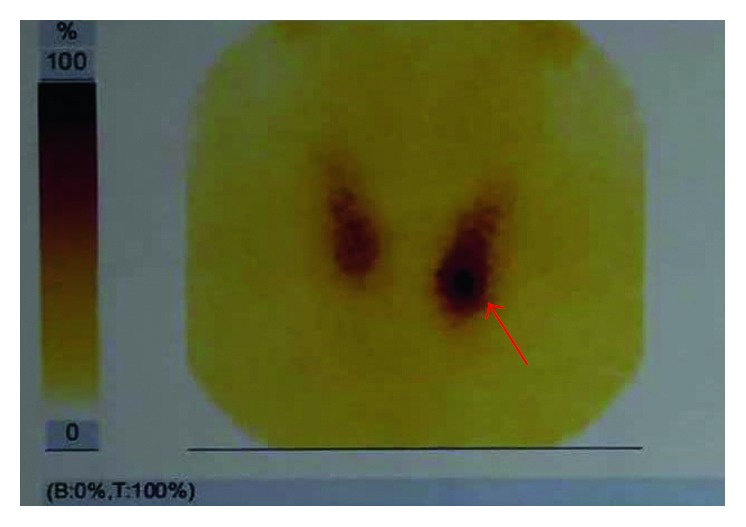
Parathyroid technetium scintiscan (99mTc Sestamibi; Technetium-99 MIBI; methoxy-isobutyl-isonitrile) showed increased uptake of the radiocontrast agent observed in the left lower parathyroid.